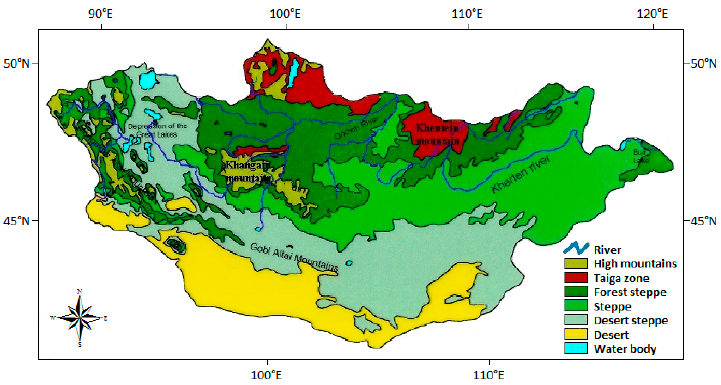
Figure 1. Land use/cover map of Mongolia (41°35 ′ N–52°09 ′ N and 87°44 ′ E–119°56 ′ E).